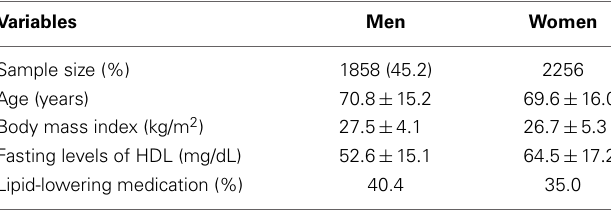
Table 1 | Characteristics of the variables studied in the GWA